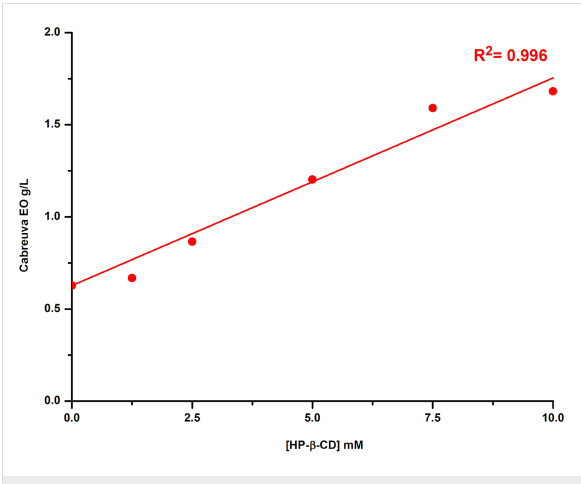
Figure 3: Phase solubility profile of cabreuva EO obtained by the TOC